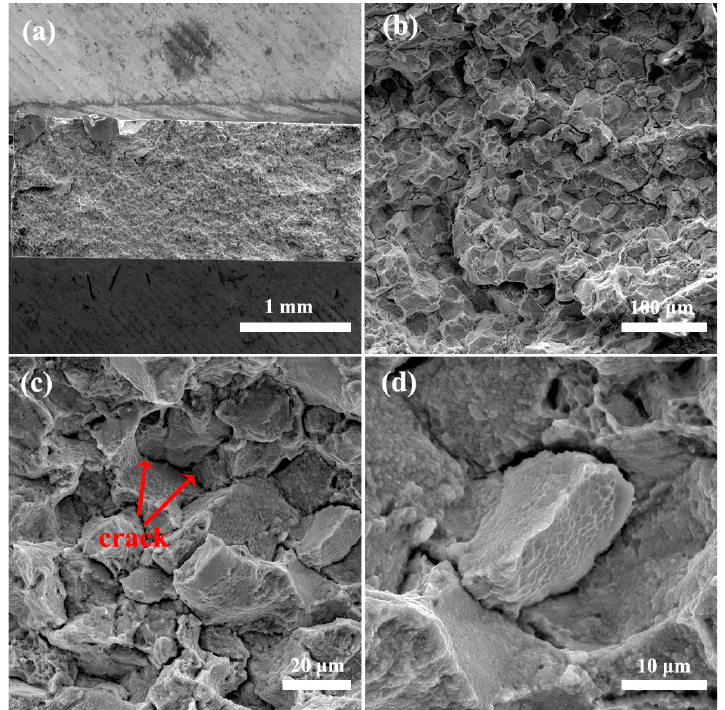
Figure 10. Fracture morphology of the forged Ti ‐ 6Al ‐ 10.9Cr alloy after tensile deformation: (a) overview microstructure, (b ‐ d) SEM images at different magnifications.